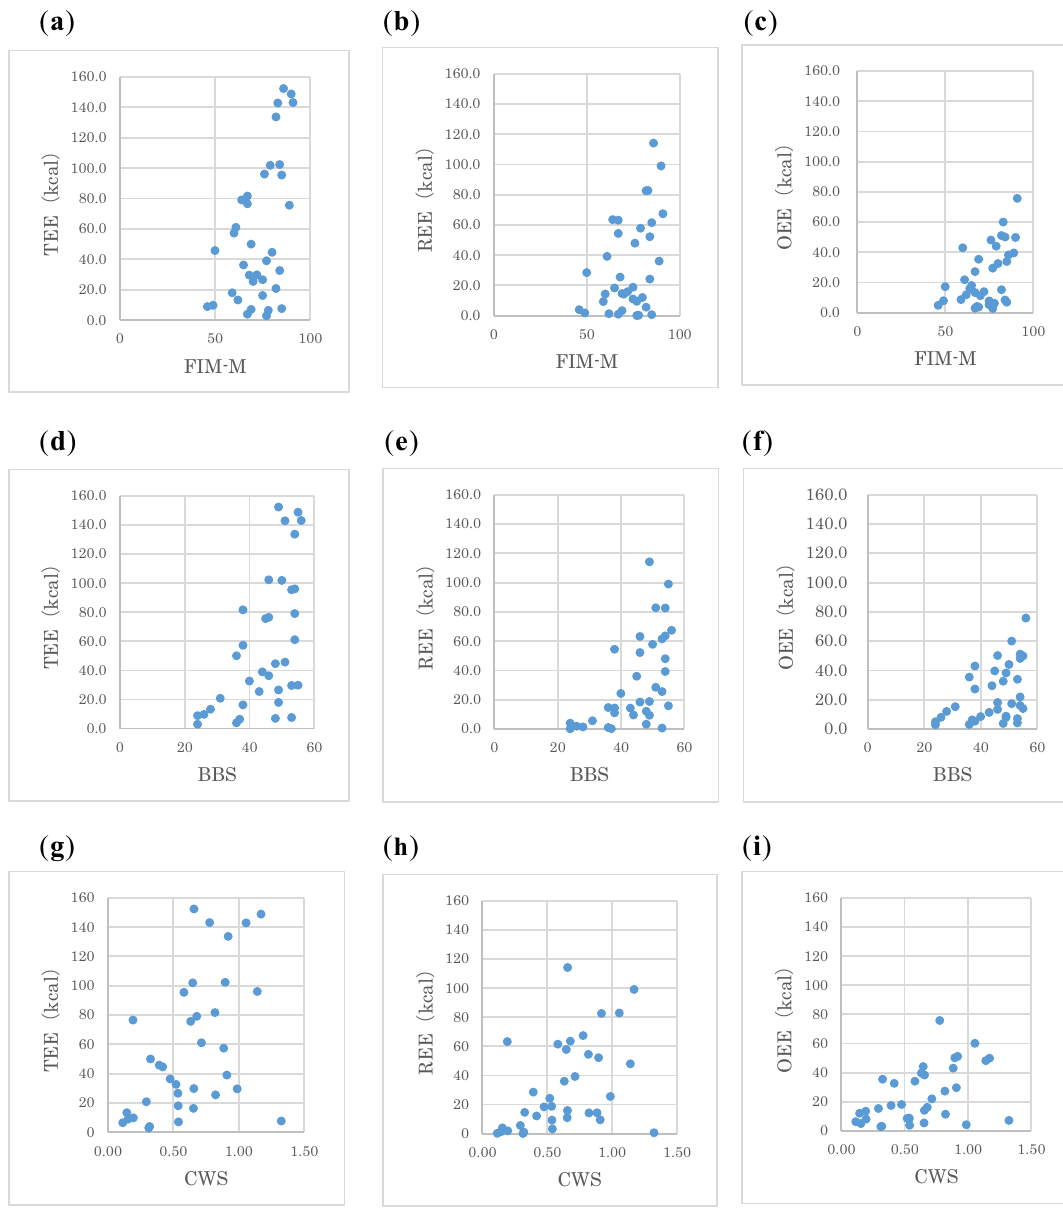
Figure 1. Scatter plots of physical function and energy expenditure (n = 36). Scatter plot of FIM-M and ( a ) TEE, ( b ) REE, and ( c ) OEE. Scatter plot of BBS and (d) TEE, ( e ) REE, and ( f ) OEE. Scatter plot of CWS and ( g ) TEE, ( h ) REE, and ( i ) OEE.